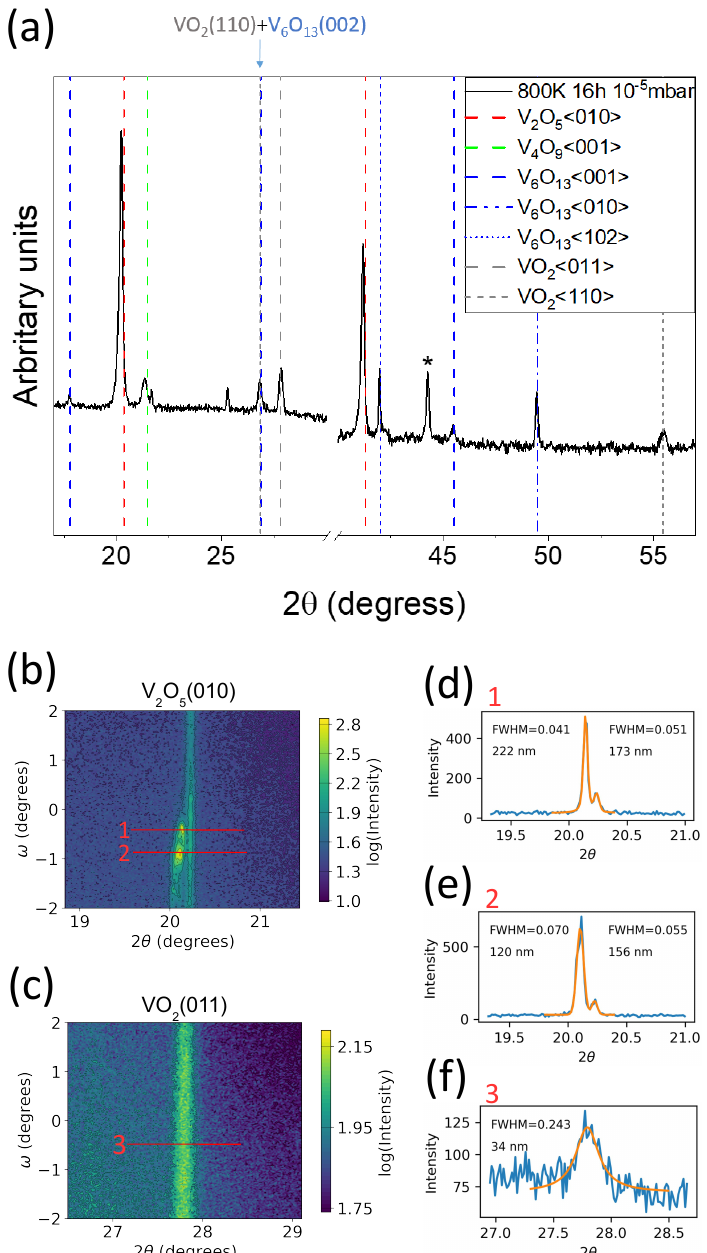
Figure 2. ( a ) θ –2 θ measurement of the annealed crystal. Peaks are attributed to V 2 O 5 , V 6 O 13 , V 4 O 9 and VO 2 . The asterisk is due to the sample stage. ( b , c ) reciprocal space map of the V 2 O 5 (010) and VO 2 (011) peaks of the annealed crystal. V 2 O 5 (010) consists of peaks and a homogeneously distributed component at slightly different lattice constants. VO 2 (011) is homogeneous within the probed angular window. The cross sections of the red line segments 1–3 are depicted in the ( d – f ). Applying the full width at half maximum of these peaks to the Scherrer equation gives the average coherent domain size. The crystallites of the VO 2 are smaller than that of V 2 O 5